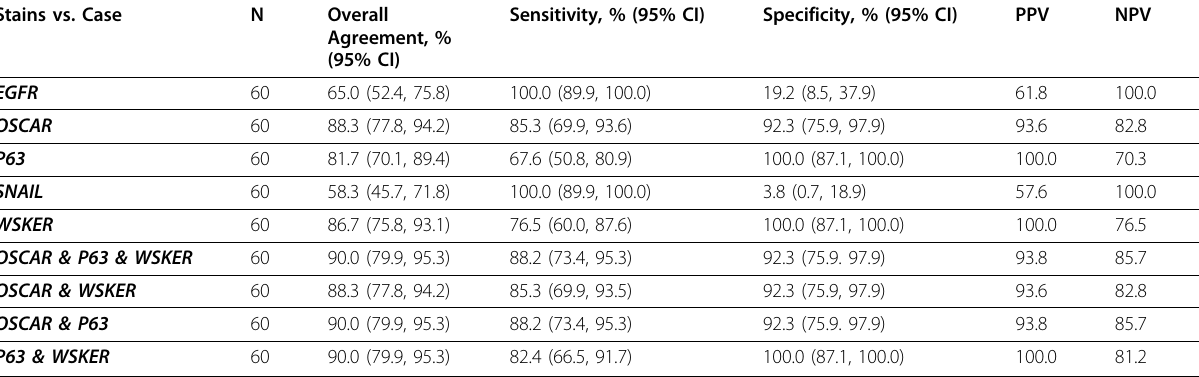
Table 4 Sensitivity, Specificity, Positive (PPV) and Negative (NPV) Predictive Values of the different immunomarkers (%) Stains vs.